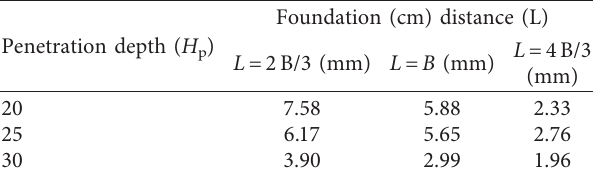
Table 10: Maximum δ max obtained from numerical analysis. Penetration depth ( H p )